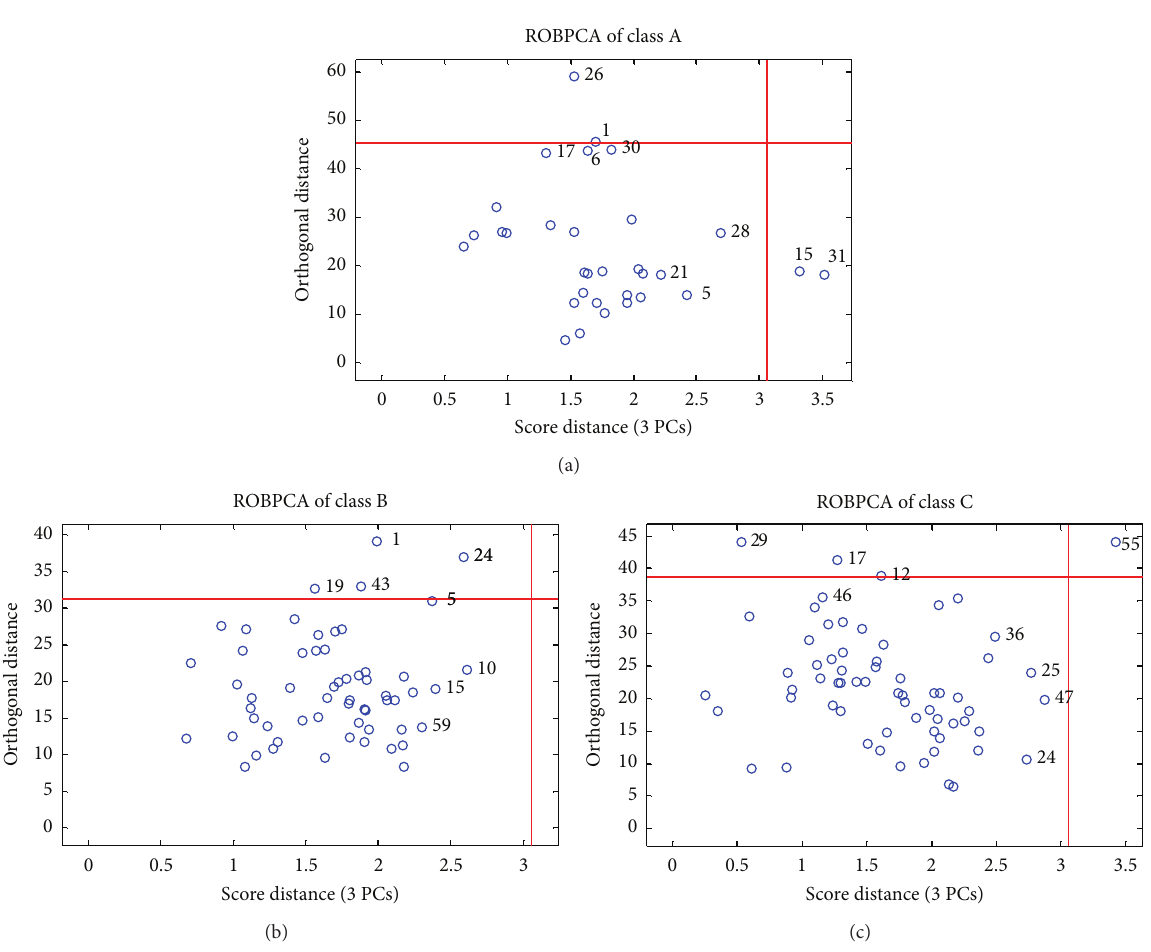
Figure 2: ROBPCA of the electronic tongue data: the outlier plots for Longjing samples from Xihu (class A), Qiantang (class B), and Yuezhou (class